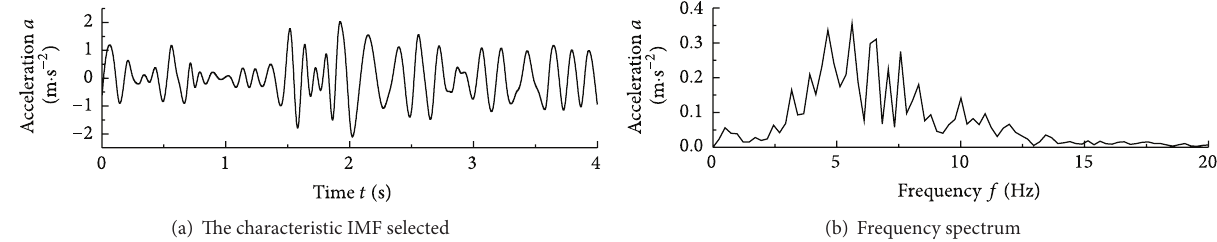
Figure 25: Analysis results of the signal presented in Figure 23 by EEMD: (a) the characteristic IMF and (b) FFT spectrum.